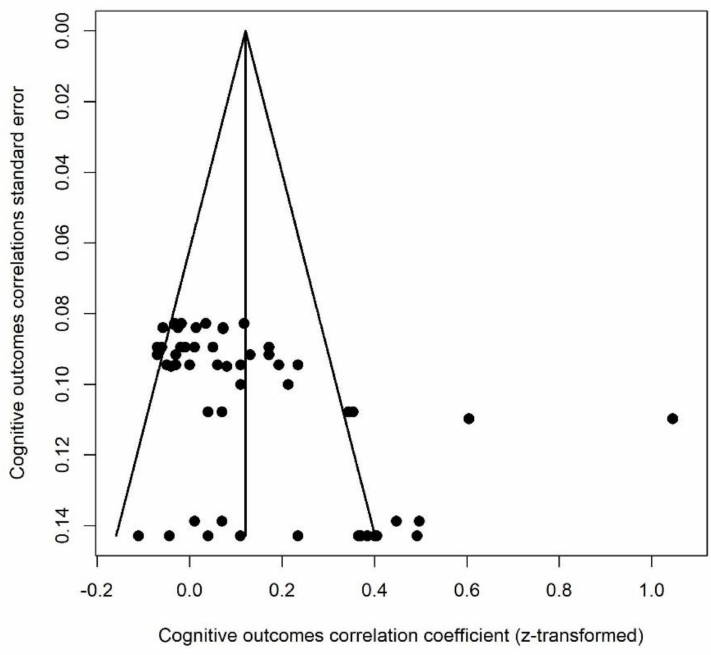
Figure 6. Cognitive outcomes funnel plot.